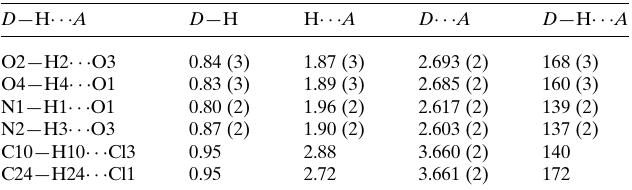
Table 1 Hydrogen-bond geometry (A˚ , (cid:2) ).